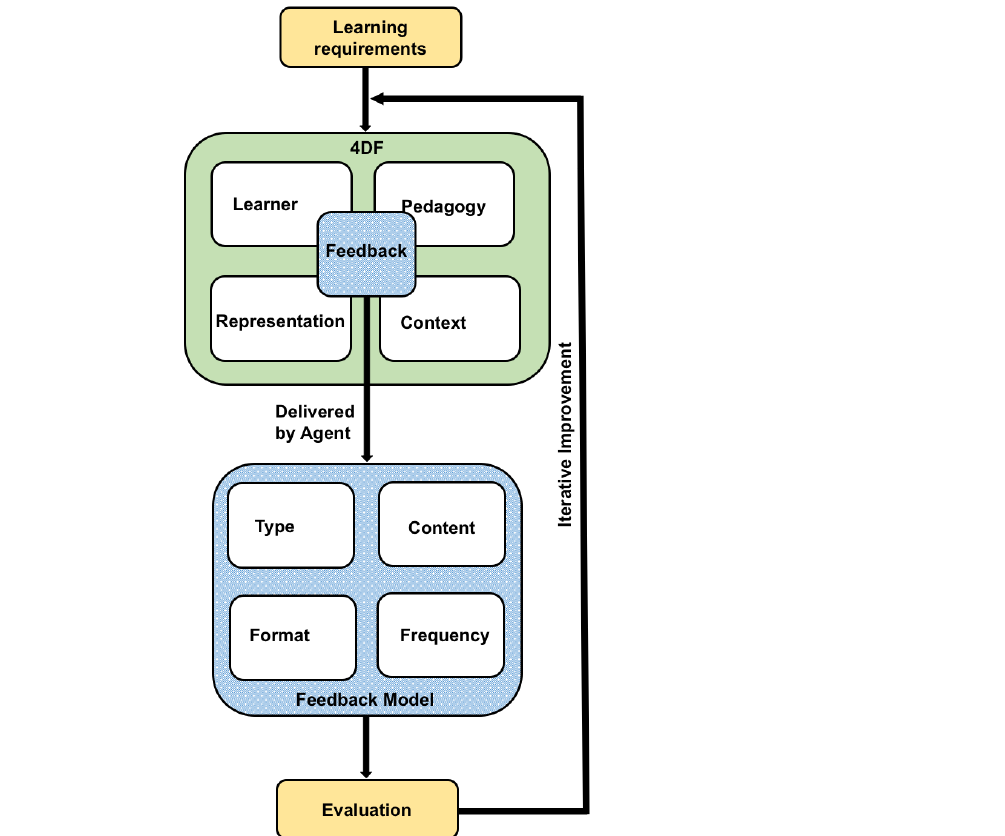
Figure 3. Four-dimensional framework (4DF) with feedback model (4F) and extension.